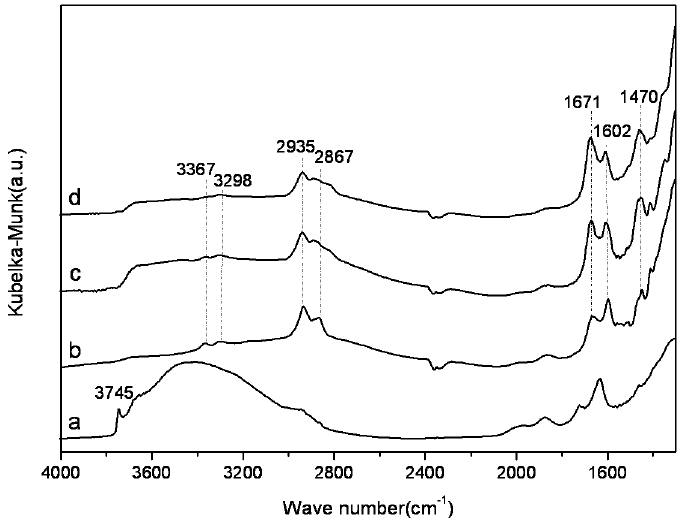
SBA-15-ex and amine-grafted SBA-15-ex. a: SBA-15-ex; b: APTMS-SBA-15-ex; c: AEAPS-SBA-15-ex; d: